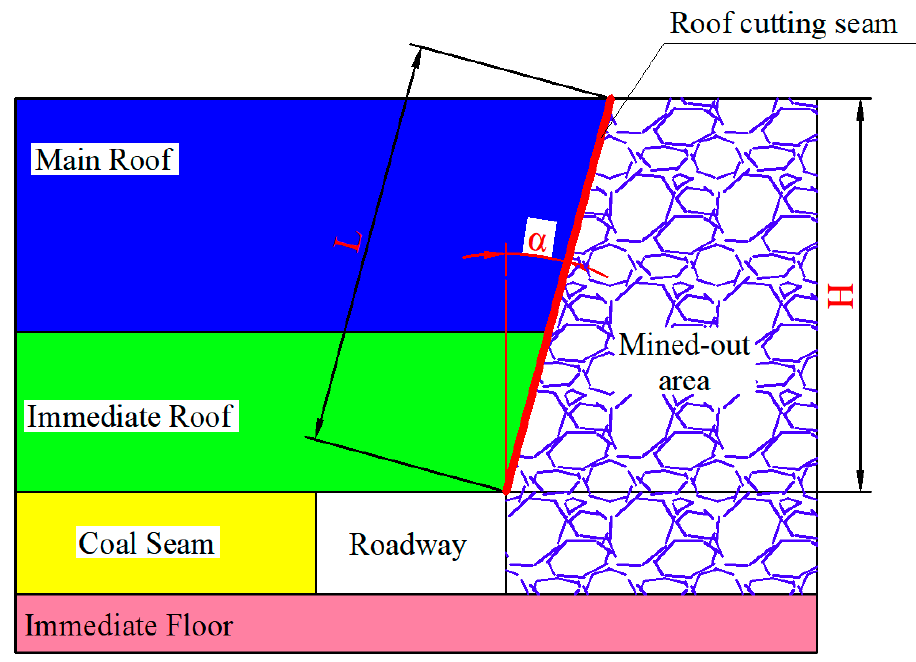
Figure 5. Roof cutting diagram.